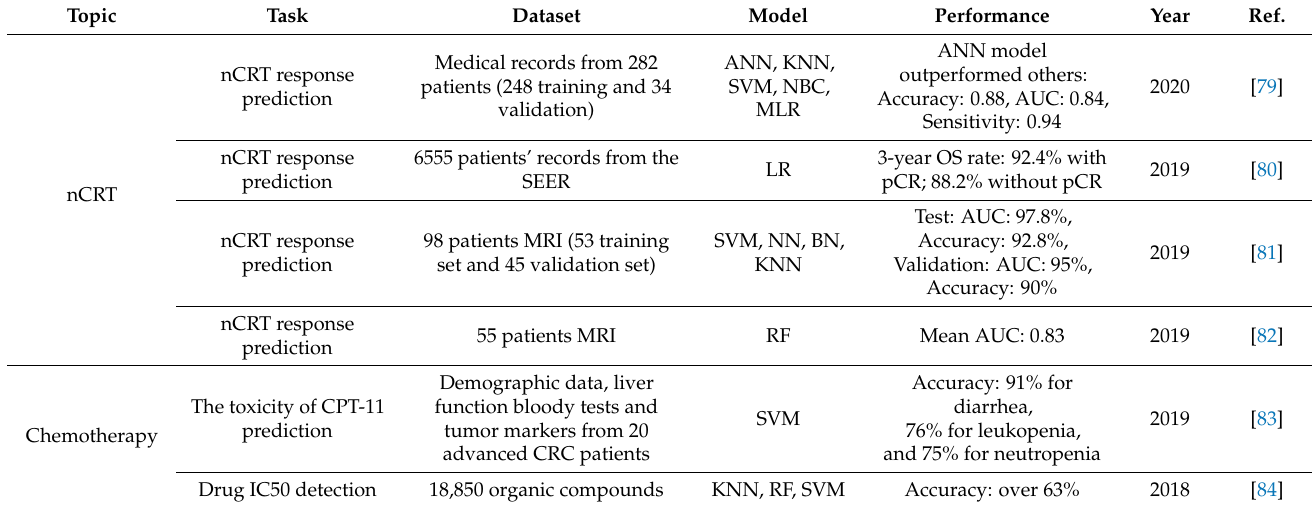
Table 3. Summary of AI applications for CRC treatment session (nCRT, neoadjuvant radiotherapy; ANN, artificial neural network; AUC, area under curve; KNN, K-nearest neighbors; SVM, support vector machine; NBC, naïve Bayesian classifier; MLR, mixed logistic regression; LR, logistic regression; NN, neural network; BN, Bayesian network; RF, random forest; CPT-11, Irinotecan; IC50, half maximal inhibitory